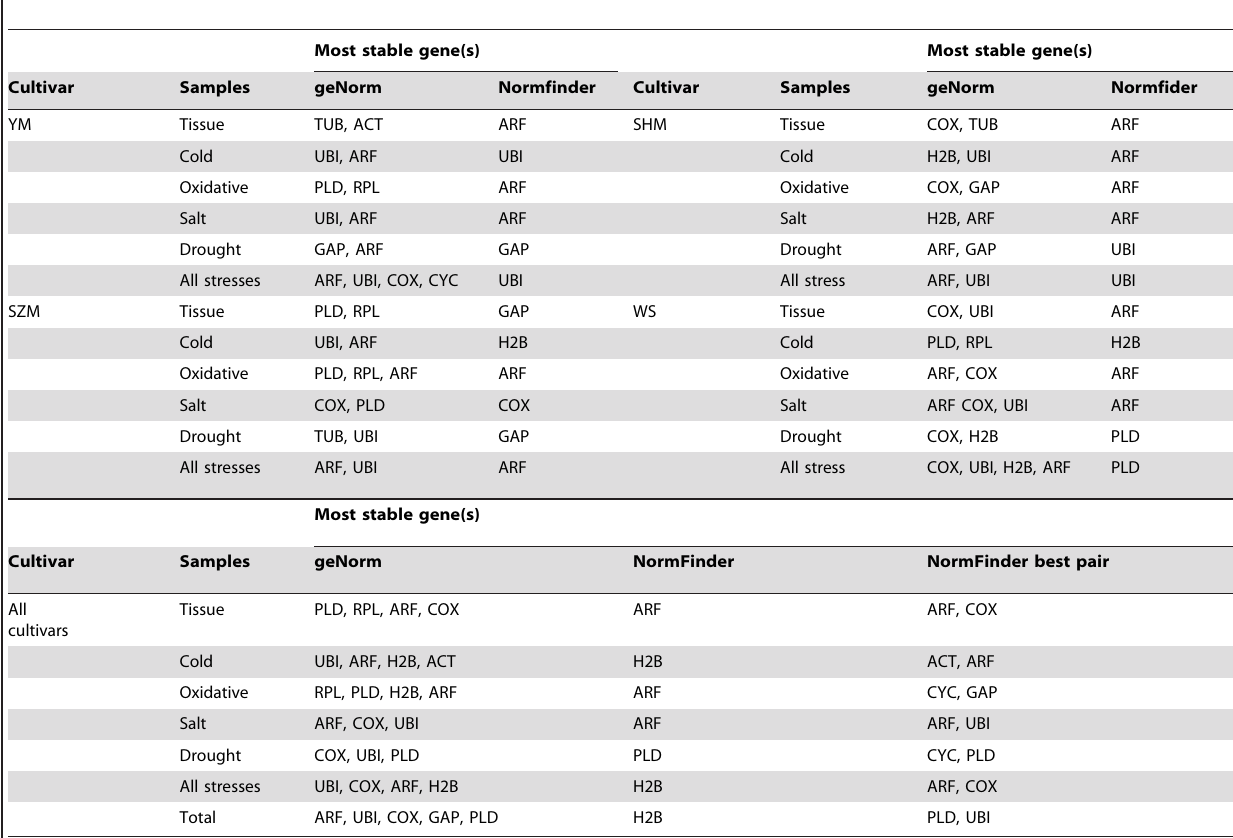
Table 2. Optimal number of stability gene(s) estimated by geNorm and Normfinder under abiotic stresses and in the tissue of each cultivar and all